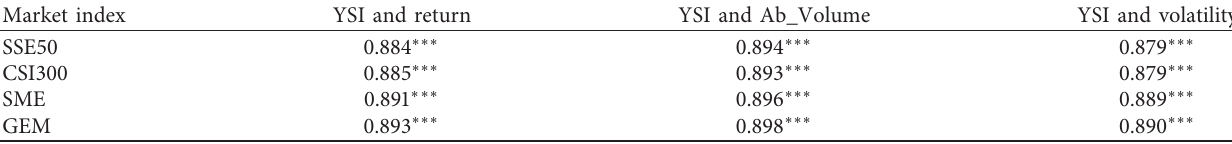
Table 2: The mutual information between Chinese stock market and market participation